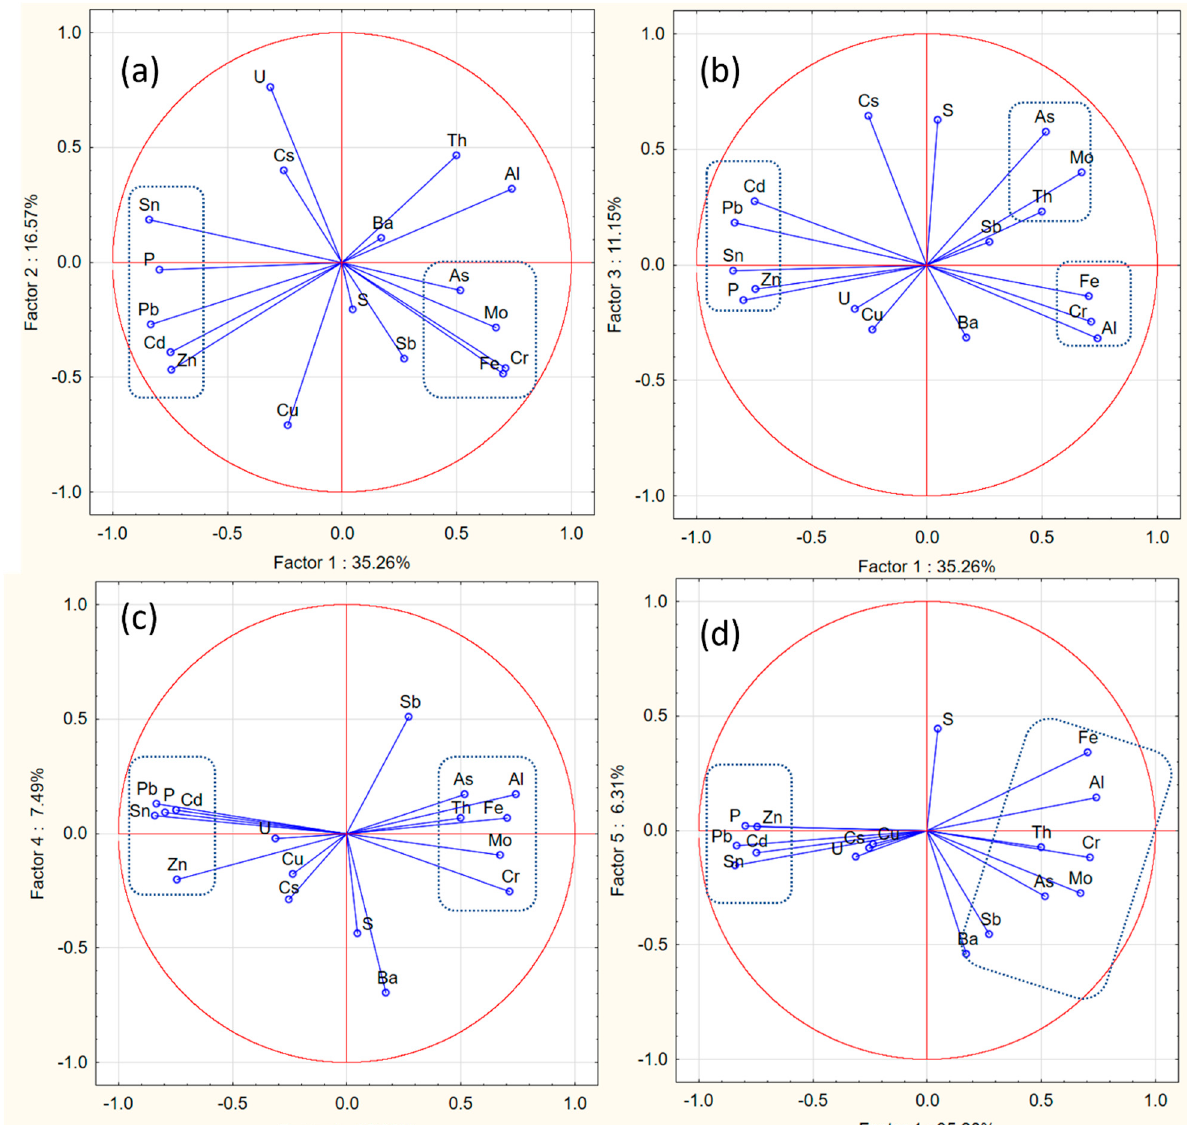
Figure 6. Biplots of the factor coordinates of the variables in the respective correlation circle (in red), comparing ( a ) principal component 1 (PC1) versus principal component 2 (PC2); ( b ) principal component 1 (PC1) versus principal component 3 (PC3); ( c ) principal component 1 (PC1) versus principal component 4 (PC4) and ( d ) principal component 1 (PC1) versus principal component (PC5).